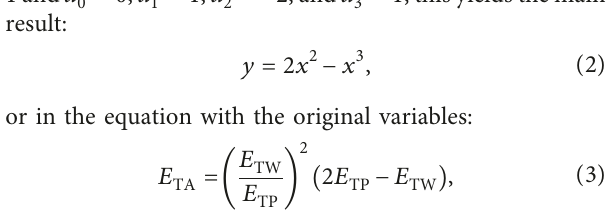
represents the actual evapotranspiration, E potential evapotranspiration, and E potential evapotranspiration under the “potential” condi- tions that the evapotranspiration water is not a limiting factor with the same solar radiation input and the same meso-alpha scale pressure gradient pattern [2].